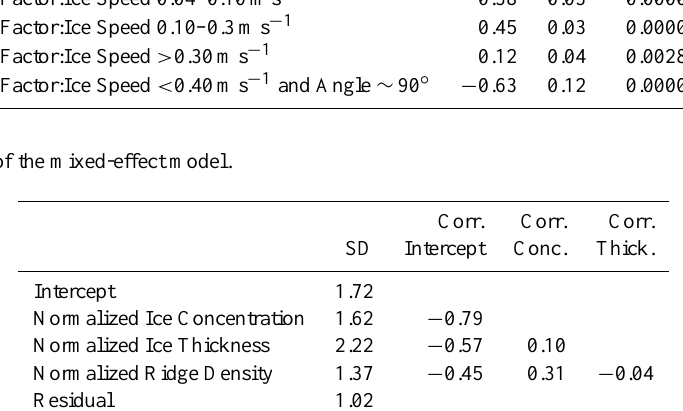
Table 2. Random components of the mixed-effect model.